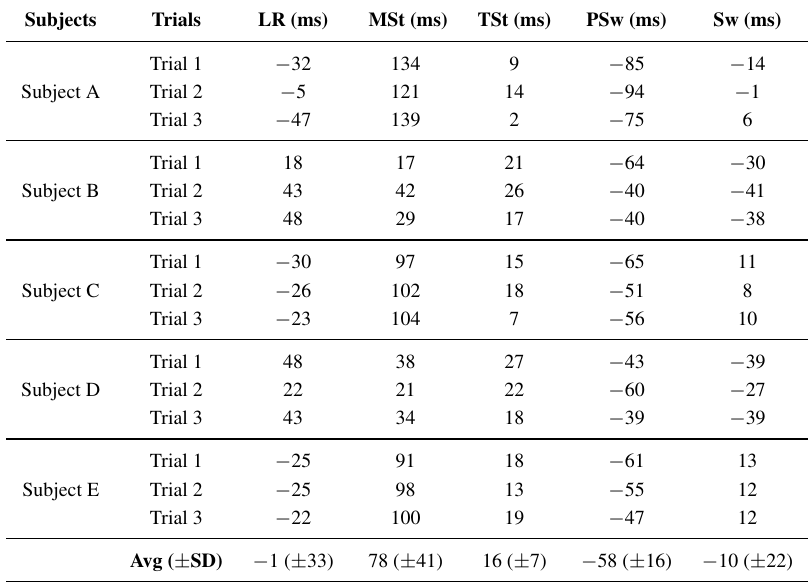
Table 5. Average duration of each estimated gait phase vs. Perry’s gait cycle (right